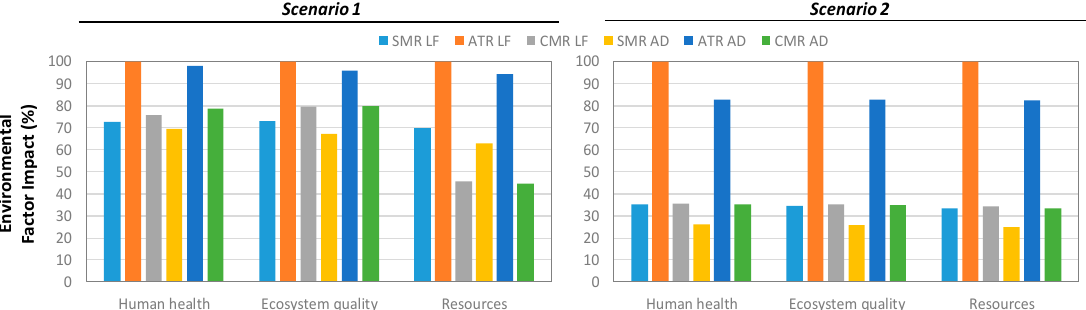
Figure 10. Comparison of endpoint environmental impact of different systems under different scenarios.